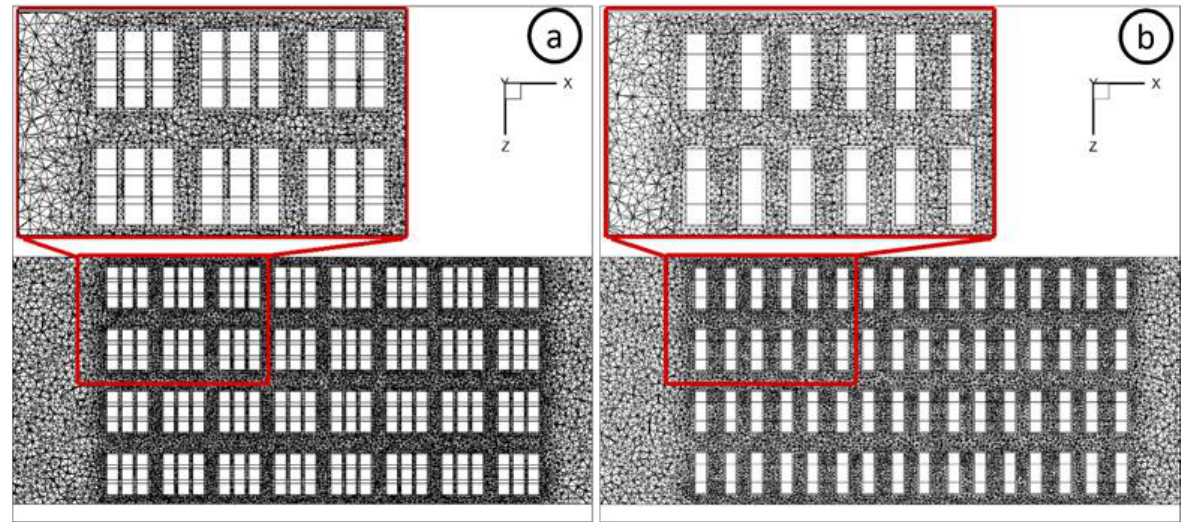
Figure 3. A grid image for the transverse bricks from the ( a ) high-density setting (HDS) and ( b ) low-density setting (LDS) using grid 3. Table 3. The computed pressure drop ( ∆𝑃 ) and surface temperature ( 𝑇 𝑠 ) of the longitudinal and transverse bricks using grid 3 and k- ω turbulence model against the measured values for the LDS. Parameter Measured Values Computed Values % Difference ∆𝑃 (Pa) 210.7 213.8 1.47 𝑇 𝑠 (K), Long. brick 323 325.1 0.65 𝑇 𝑠 (K), Trans. brick 325 326.5 0.46